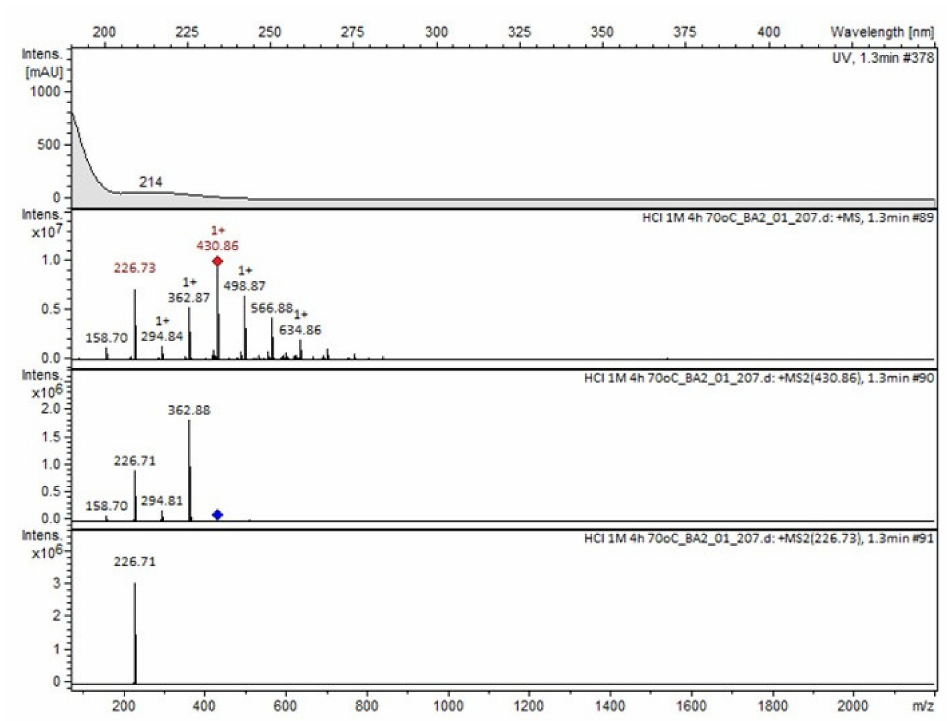
Figure 6. MS and UV/VIS spectra of Compound